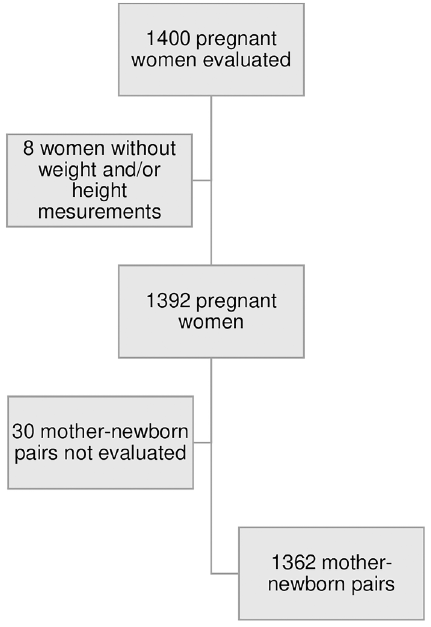
BMI: body mass index; ABEP: Brazilian Association of Research Companies. *Unknown values were